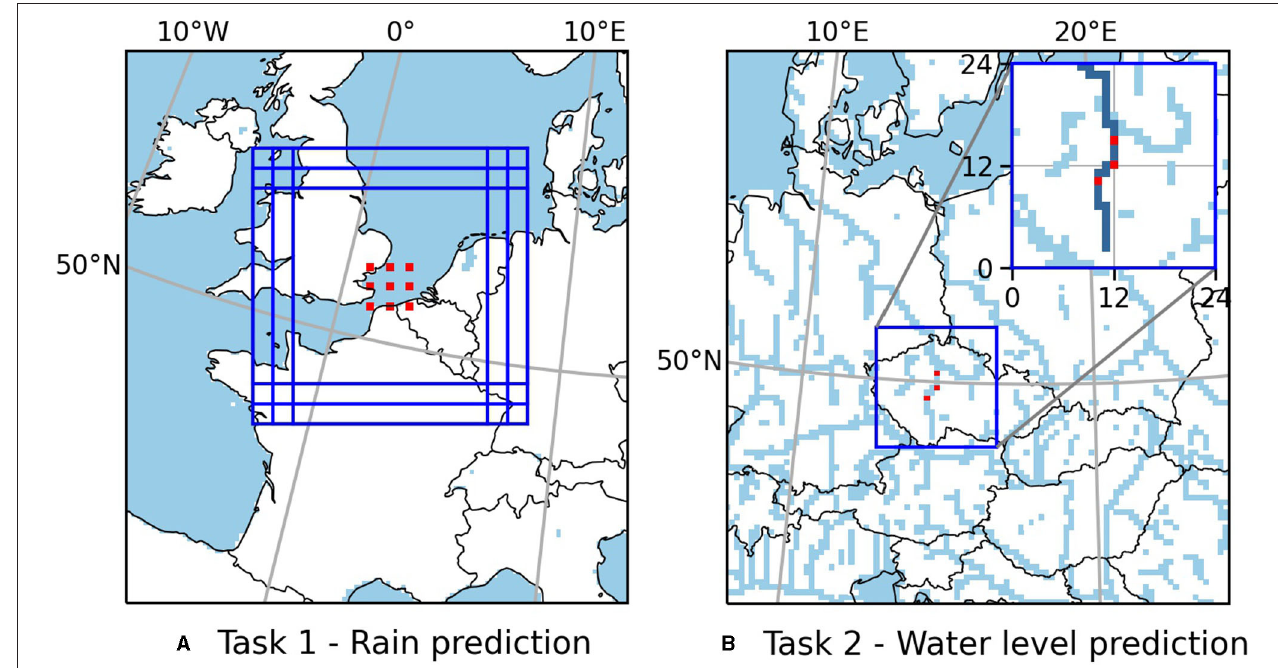
FIGURE 2 | Location variant tasks. (A) Original target patch (center) with its input region and eight additional target patches and their (overlapping) input regions. (B) Original target location (center) and two additional target locations closely upstream and